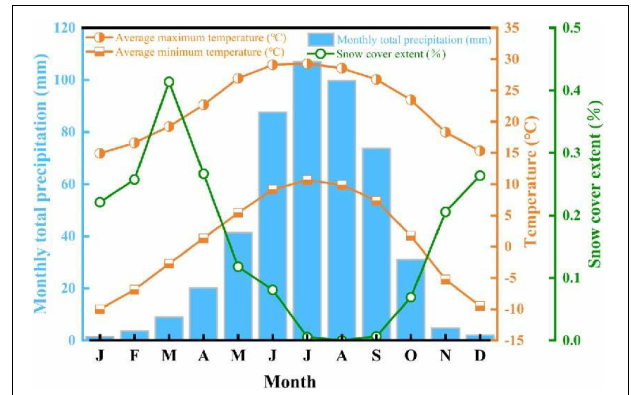
FIGURE 2 | The pattern of monthly maximum (T max ), minimum (T min ), temperature ( ◦ C), and monthly total precipitation (Pre) (mm) for the period of 1954–2018 and the gridded snow cover extent (SCE) (%) for